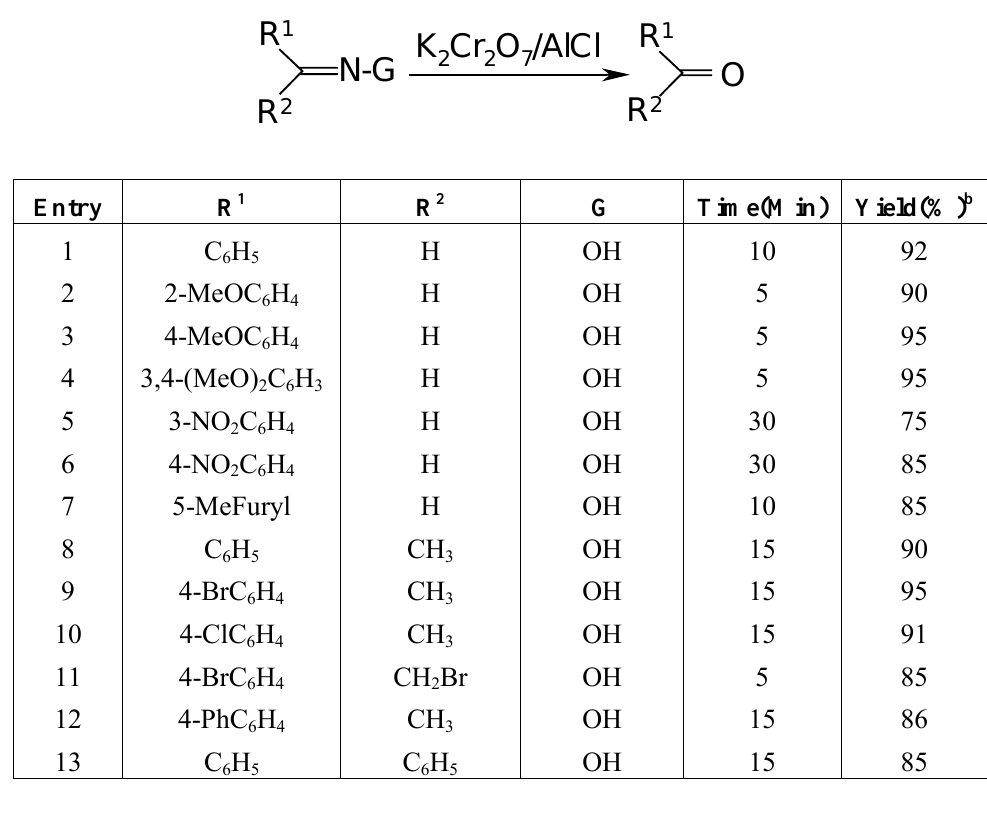
Table 3. Conversion of Oximes and Semicarbazones to Carbonyl Compounds